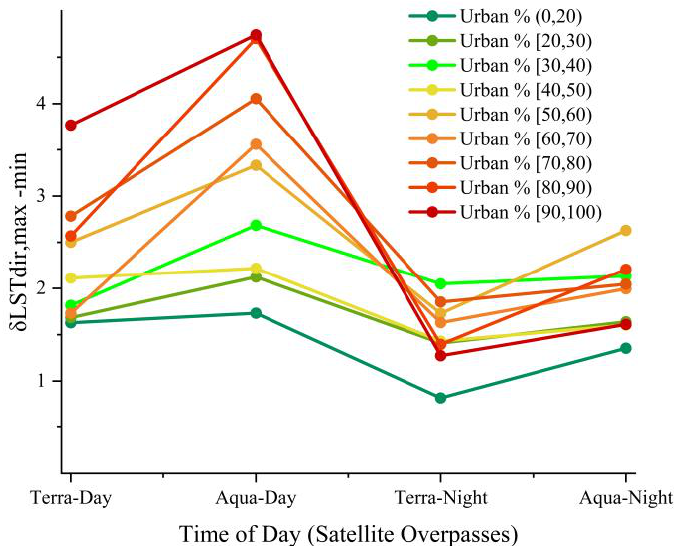
Figure 5. Effective thermal anisotropy under different land-use intensity groups, at each satellite overpass time. The abscissa represents the four overpass times, the ordinate represents the effective thermal anisotropy, and the colored solid line represents the effective thermal anisotropy of the land-use intensity groups.